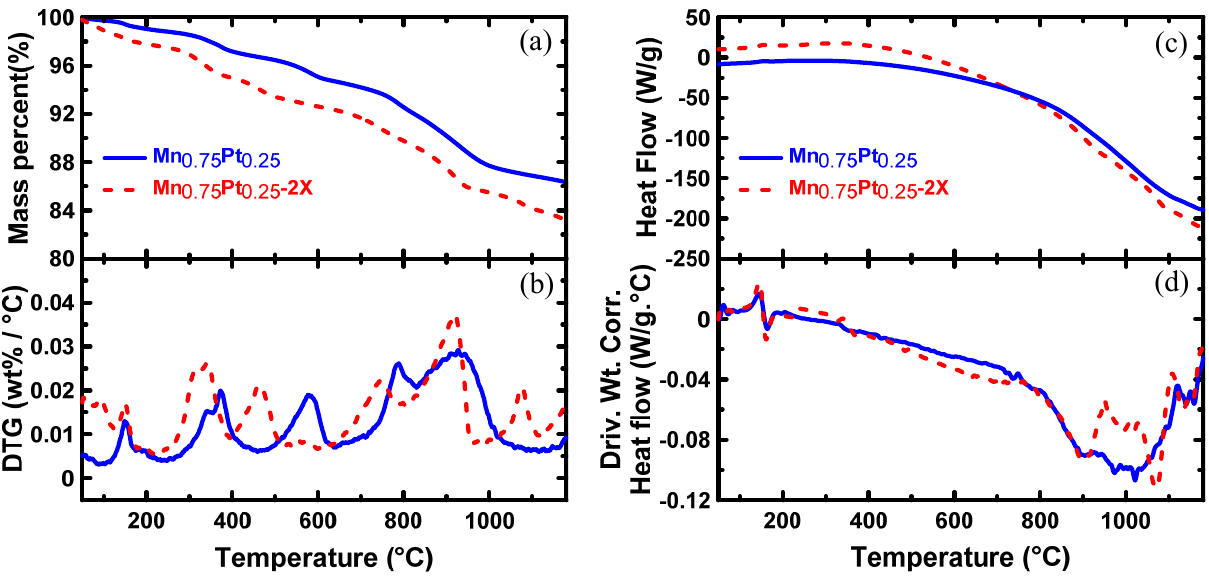
Figure 1. ( a ) TG, ( b ) DTG, ( c ) DSC and ( d ) derivative weight-corrected DSC for